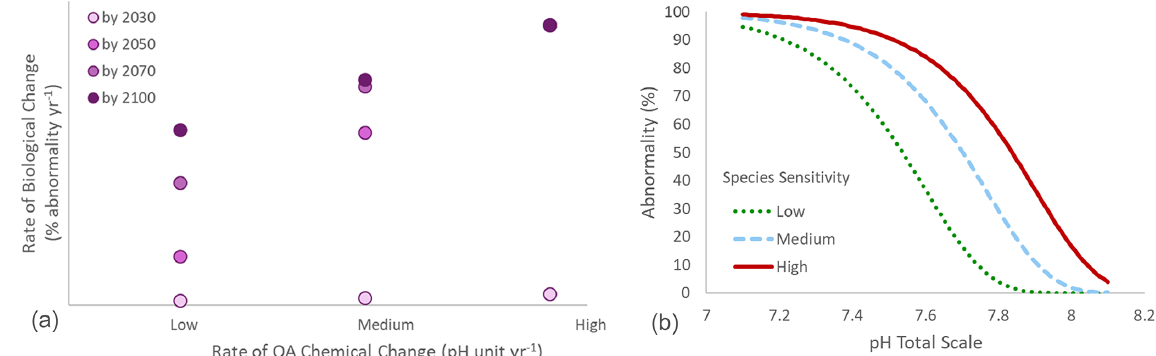
Figure 3. (a) Conceptual relationship between the rate of chemical change (e.g., pH units per year) and the rate of biological change (e.g., percent of change per year) under three different scenarios of rates of chemical change (low, medium, and high). Rates of chemical and biological changes are positively correlated. The rates of biological change calculated by 2100 are compared with rates calculated after 10, 30, and 50 years of observation. After 10 years, the rate of biological change is dramatically underestimated compared to the rate observed by 2100. Under a low rate of chemical change, the rate of biological change is still underestimated after 50 years of observation. Under high chemical rates of change, similar biological rates of change can be calculated after 30, 50, and 80 years of observations. (b) Relationship between pH and larval abnormality (%) in three hypothetical organisms with different sensitivity: low, medium, and high, with tipping points reached at pH7.6, 7.75, and 7.9, respectively. The medium scenario is based on the mussel Mytilus edulis (from Ventura et al.,